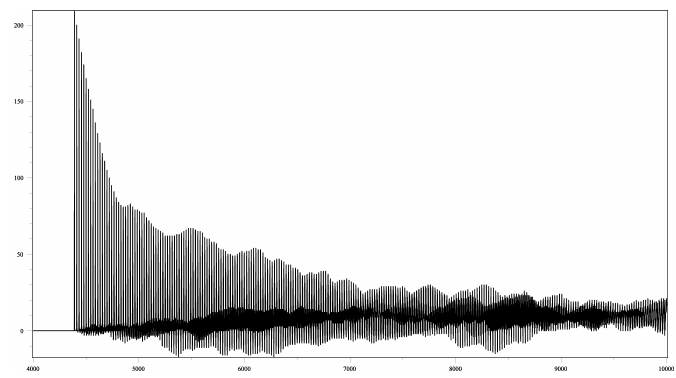
⋅ n for 4000 ≤ n ≤ 10000 . 21